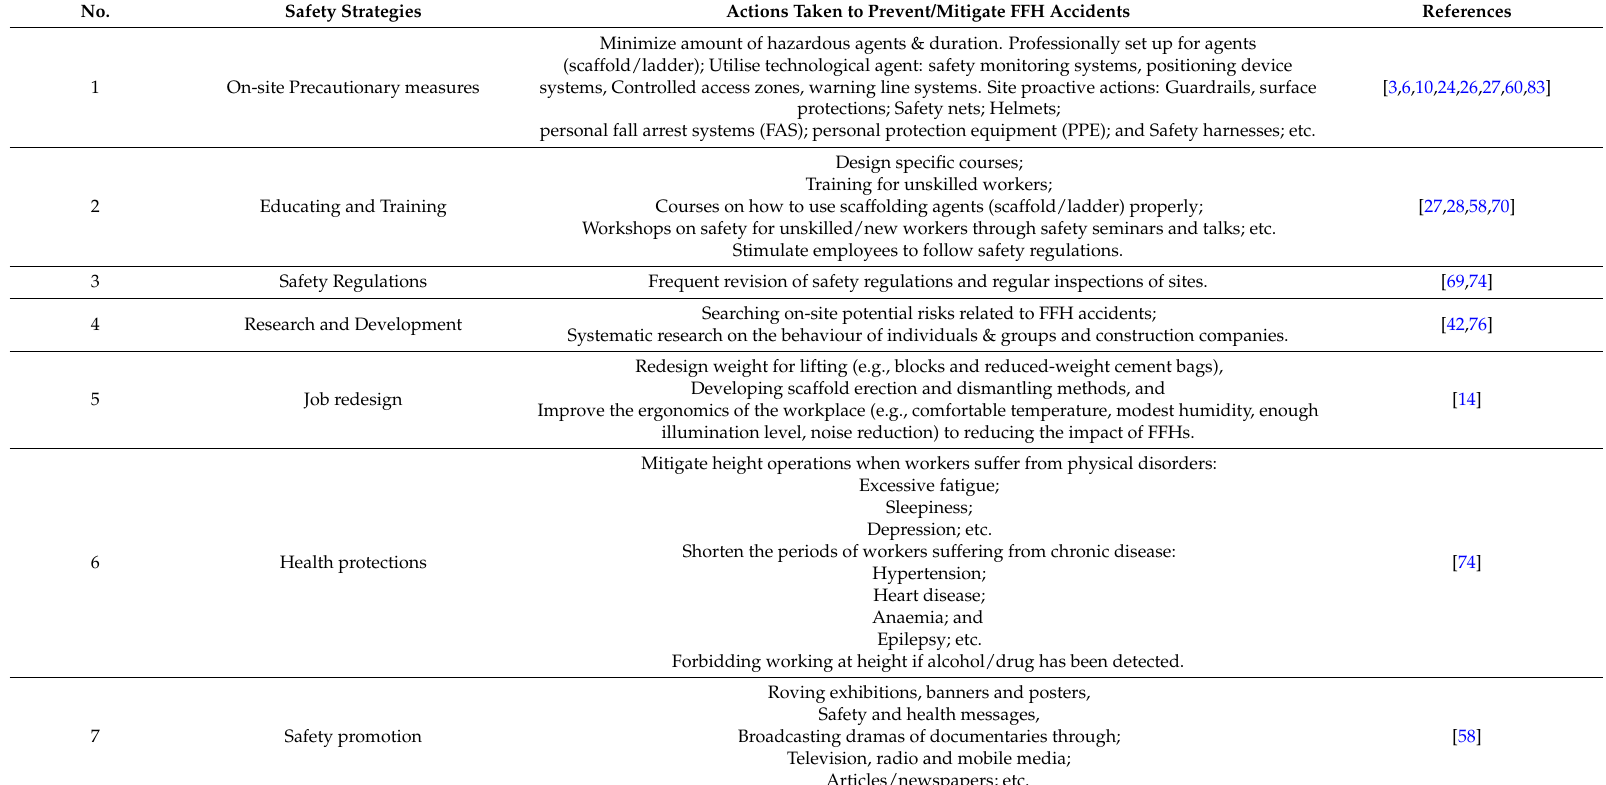
Table 11. Methods to reduce/prevent work-related